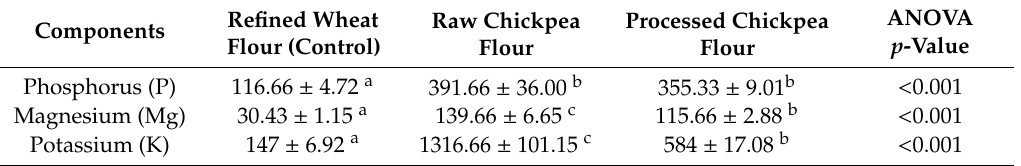
Table 4. Macromineral content of refined wheat flour, as well as raw and processed chickpea flours (mg / 100 g) dry weight